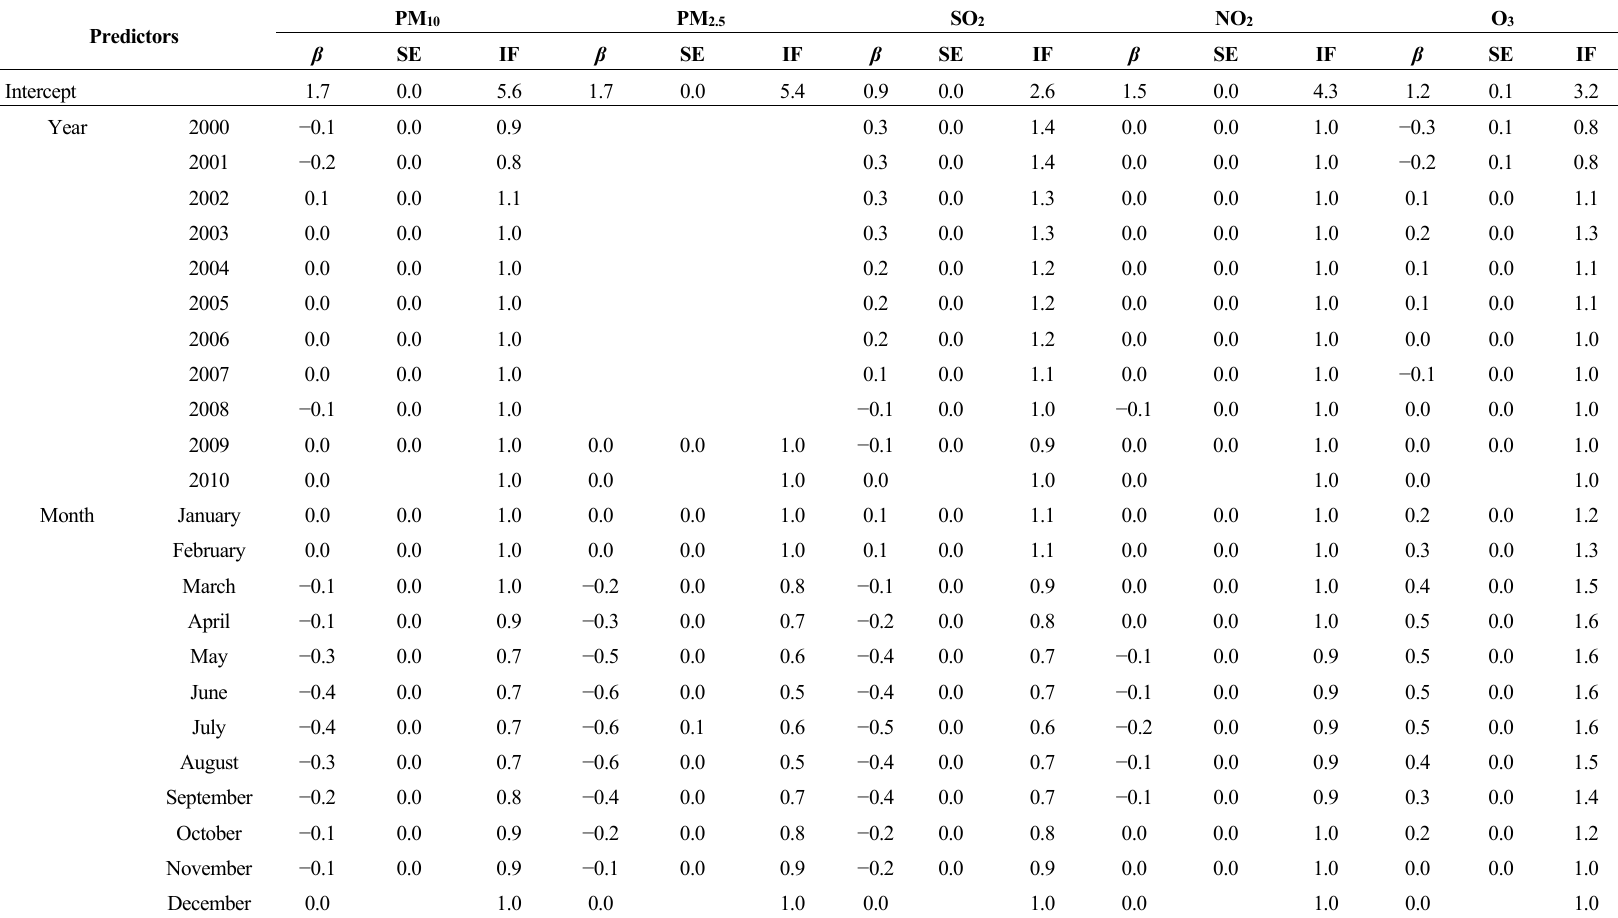
Table A1. Mixed-Effects models of PM 10 , PM 2.5 , SO 2 , NO 2 , and O 3 . IF stands for impact